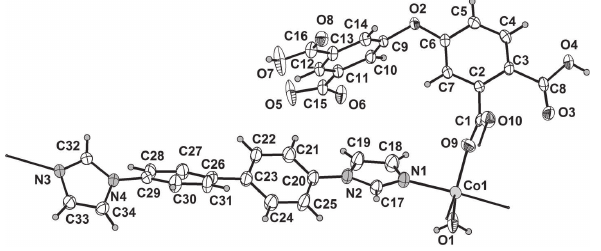
Table 1: Data collection and handling.